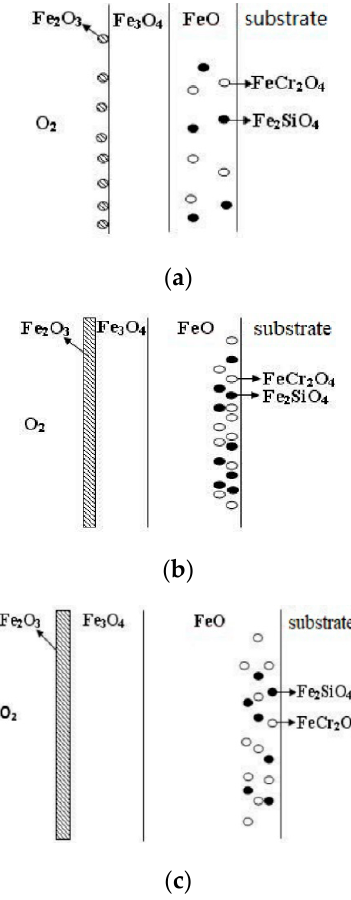
Figure 15. Schematic diagram of the cross-sectional micrograph obtained at different temperatures for the Fe–1Cr–0.2Si steel. ( a ) 900 °C; ( b ) 1000 °C; ( c ) 1100 °C.